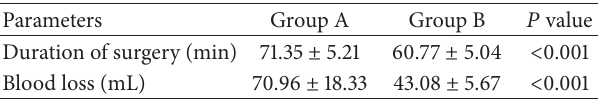
Table 2: Comparison of blood loss and duration of surgery between groups A and B. Parameters Group A Group B 𝑃 value Duration of surgery (min) 71.35 ±